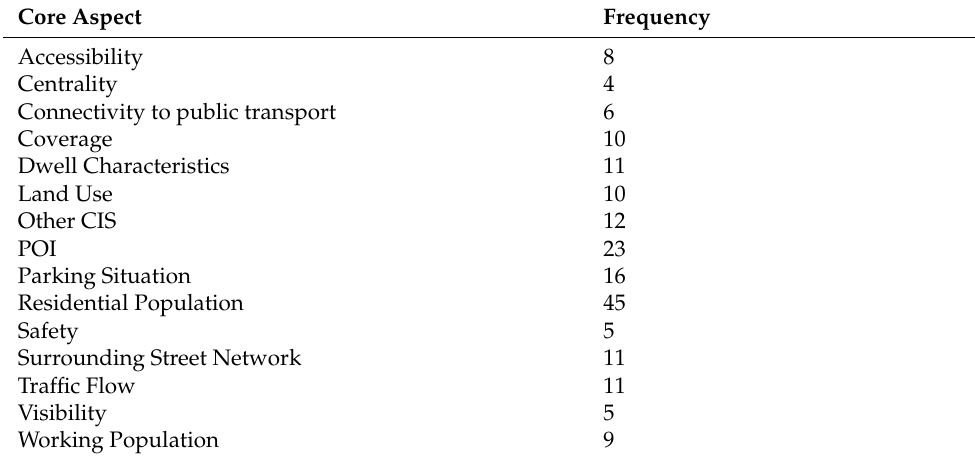
Table 1. The aspects Residential Population , POI , and Parking Situation are mentioned most frequently in our literature body, while Centrality , Safety , and Visibility are included the least. Table 1. Core aspect